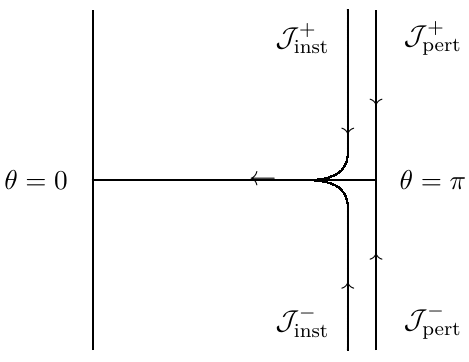
Figure 16 . The steepest descent contours for the action (8.5) in the complex θ plane for x 2 > 1